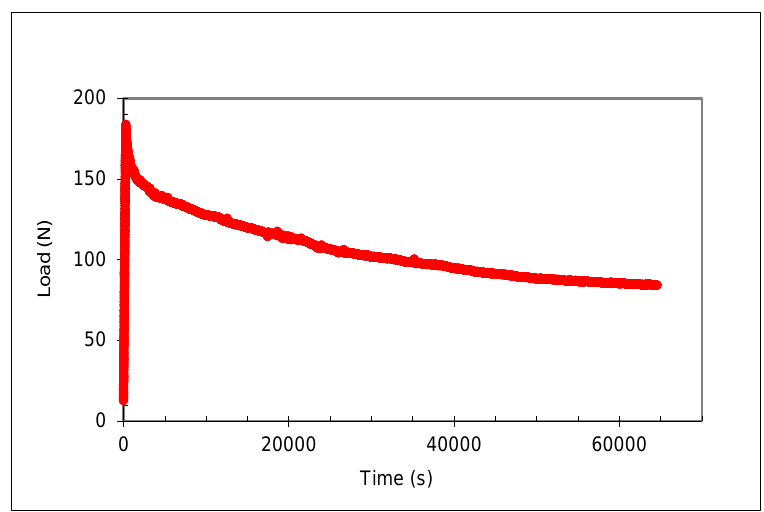
Figure 2. Typical load relaxation recorded during a static fatigue test under strain-controlled condition on E-glass fibre tow.